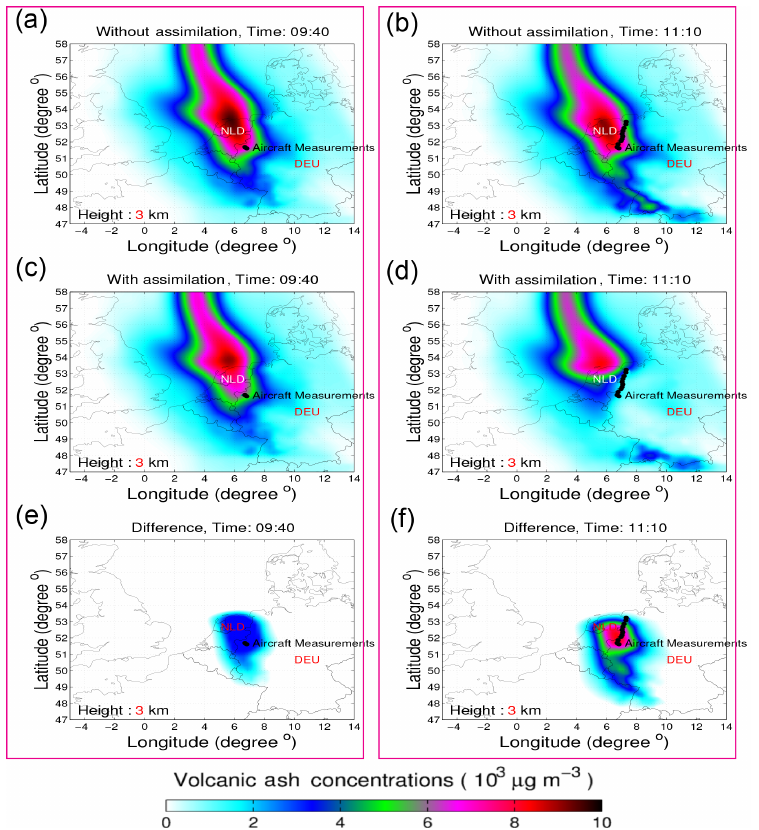
Figure 3. Comparison with and without assimilating aircraft in situ measurements on 18 May 2010. (a, b) Simulation results without assim- ilation at 09:40 and 11:10UTC. (c, d) , Simulation results with assimilation at 09:40 and 11:10UTC. (e) Differences of (a, c) . (f) Differences of (b, d) . The differences are in absolute values which are obtained by numerically subtracting the values between (a, c) , or (b, d) . Panels (e, f) represent the areas where the assimilation has